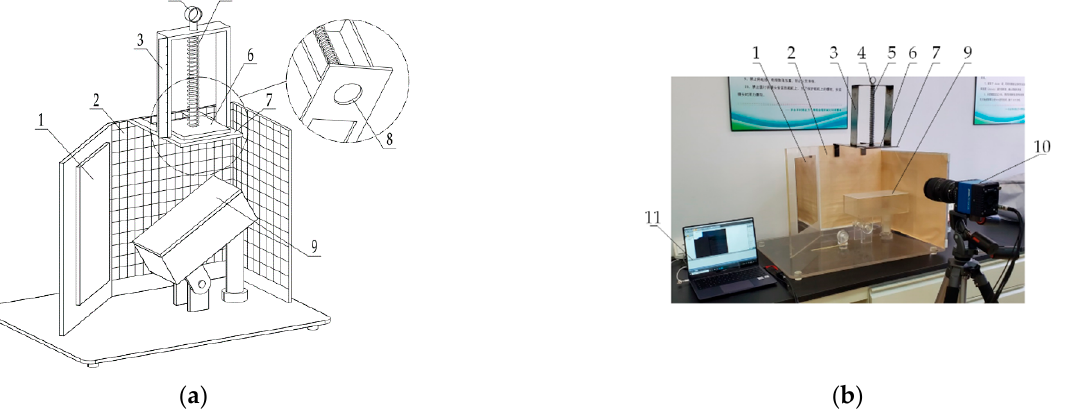
Figure 3. Test for determination of coefficient of restitution: ( a ) schematic diagram of impact test-bed; ( b ) overall structure. 1. Mirror; 2. coordinate paper; 3. spring ruler; 4. ring handle; 5. spring; 6. seed sticking plate; 7. limit baffle; 8. seed dropping opening; 9. collision platform; 10. high-speed camera; and 11.